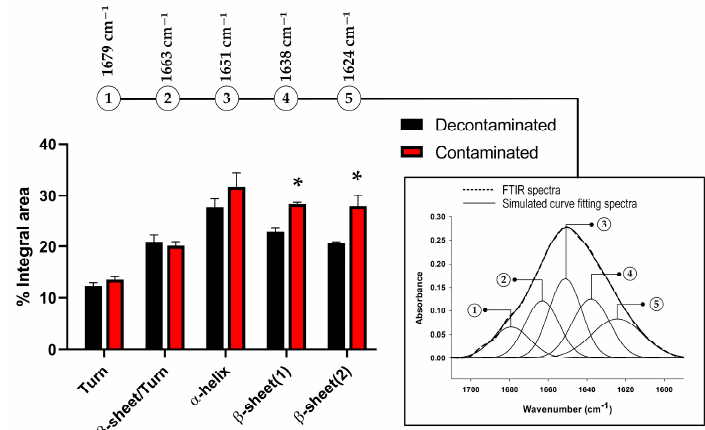
Figure 6. A percentage of the integral area of the secondary structure proteins corresponds to a curve-fitting analysis. Inset graphic illustrates FTIR absorbance of amide I band contour with best-fit 50% Gaussian / Lorentzian individual component bands. RMS error < 0.005 in all treatment groups. Data are presented as mean ± SD (n = 3). *, p < 0.05, paired t - test.